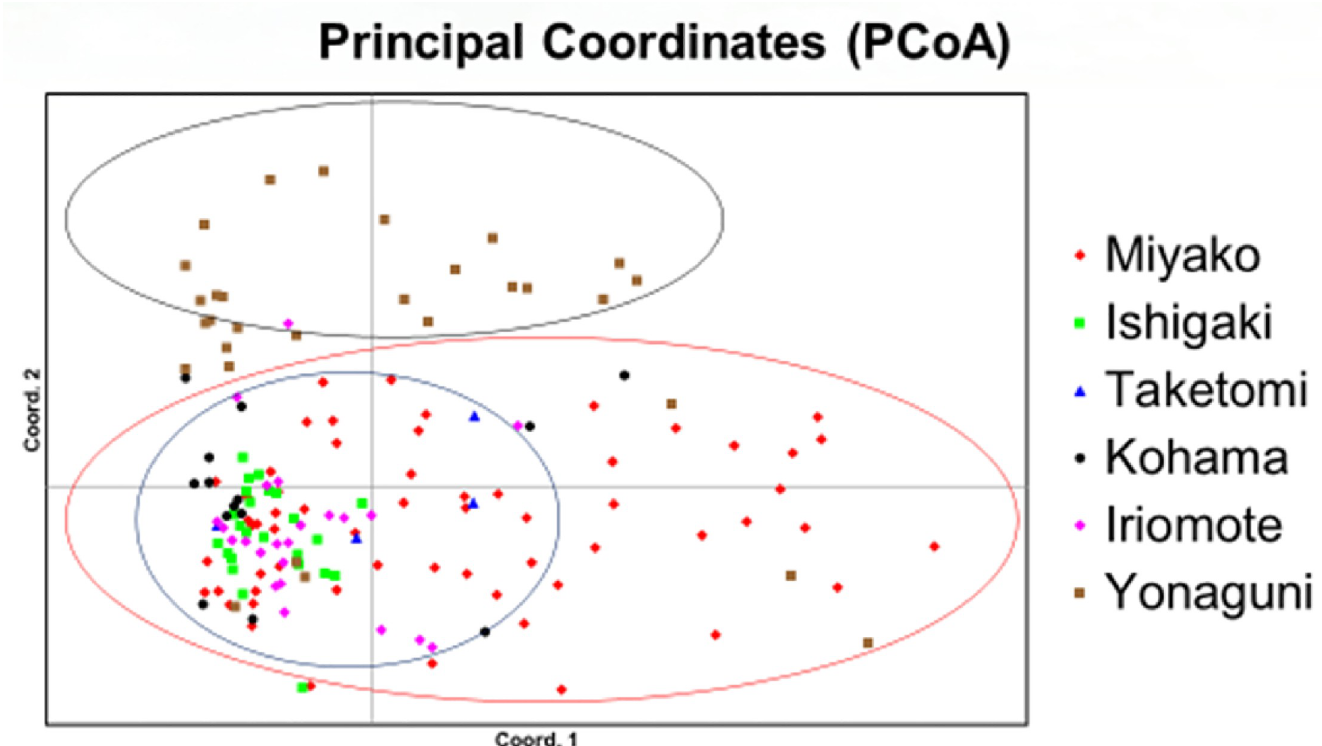
Fig 2. Principal Coordinates (PCoA) based on microsatellite genotype. Each dot represents an individual and populations are shown with colors. Three clusters are shown with circles.